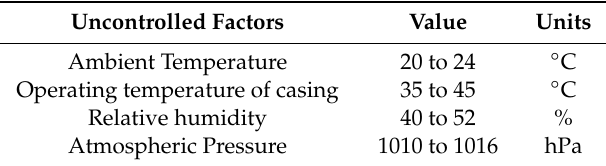
Table 4. Uncontrolled variables in the design of